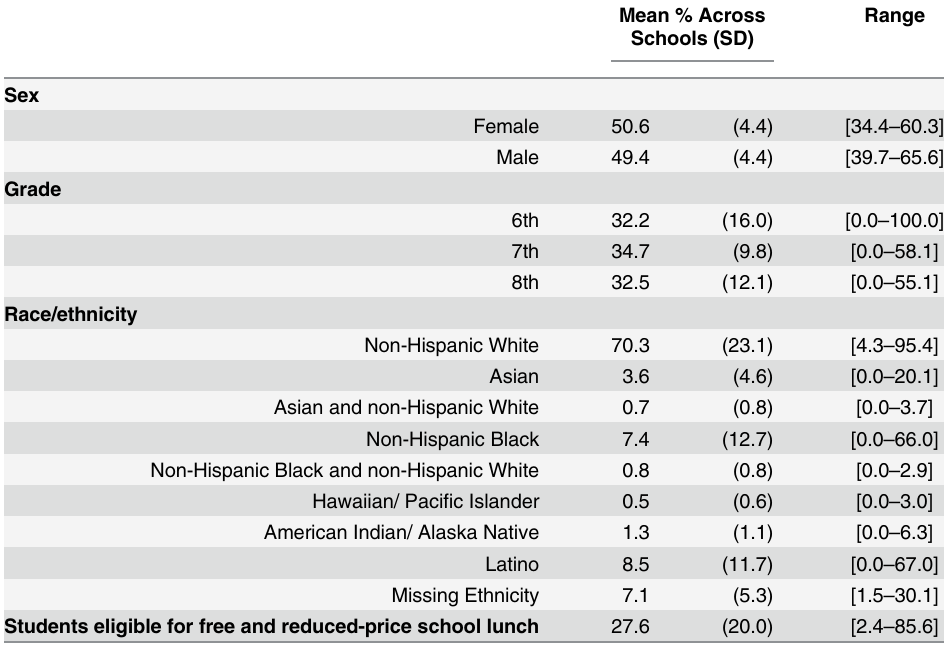
Table 1. Baseline Socio-demographic Characteristics of Schools Participating in Massachusetts Healthy Choices (n =